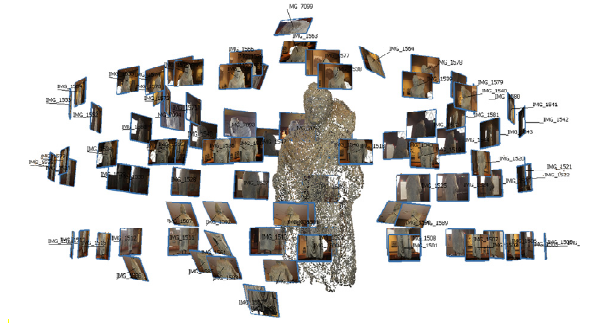
Figure 7 . Photographic shooting carried out on the Gandhāra Buddha: plan and elevation points scheme.